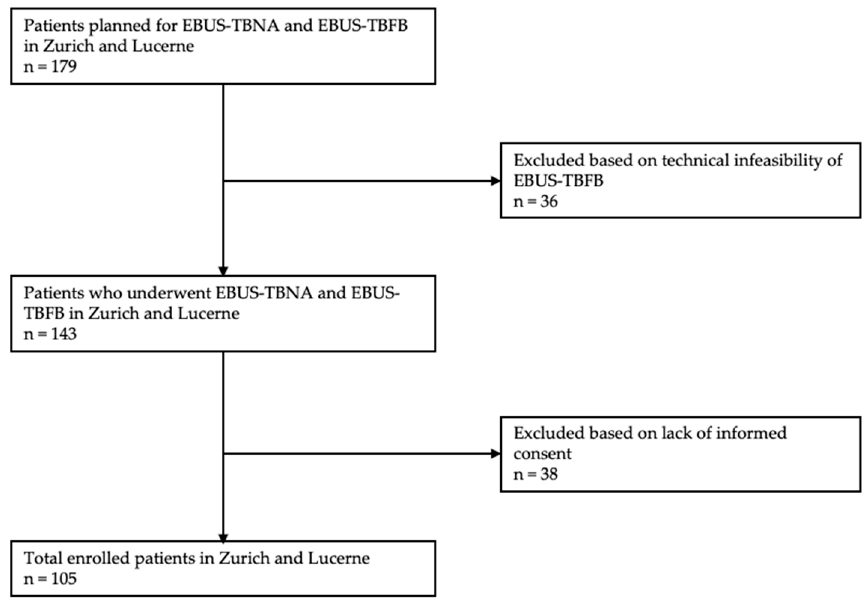
Figure 1. Patient flow. Abbreviations: EBUS = endobronchial ultrasound, TBNA = transbronchial needle aspiration, TBFB = transbronchial forceps biopsy. Table 1. Distribution and size of lymph nodes/tumors examined by EBUS-TBFB and EBUS-TBNA.